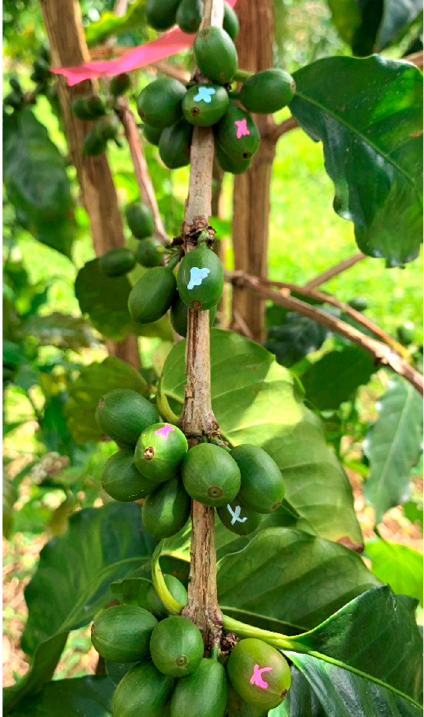
Figure 2. Coffee berries were marked with oil-based pens of different colors to identify initial and new infestations by coffee berry borers during the trial. Marks were placed away from the entry holes.